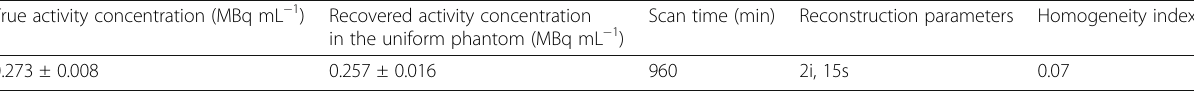
Table 1 Validation phantom. Recovered activity concentration in the uniform cylindrical phantom after an overnight